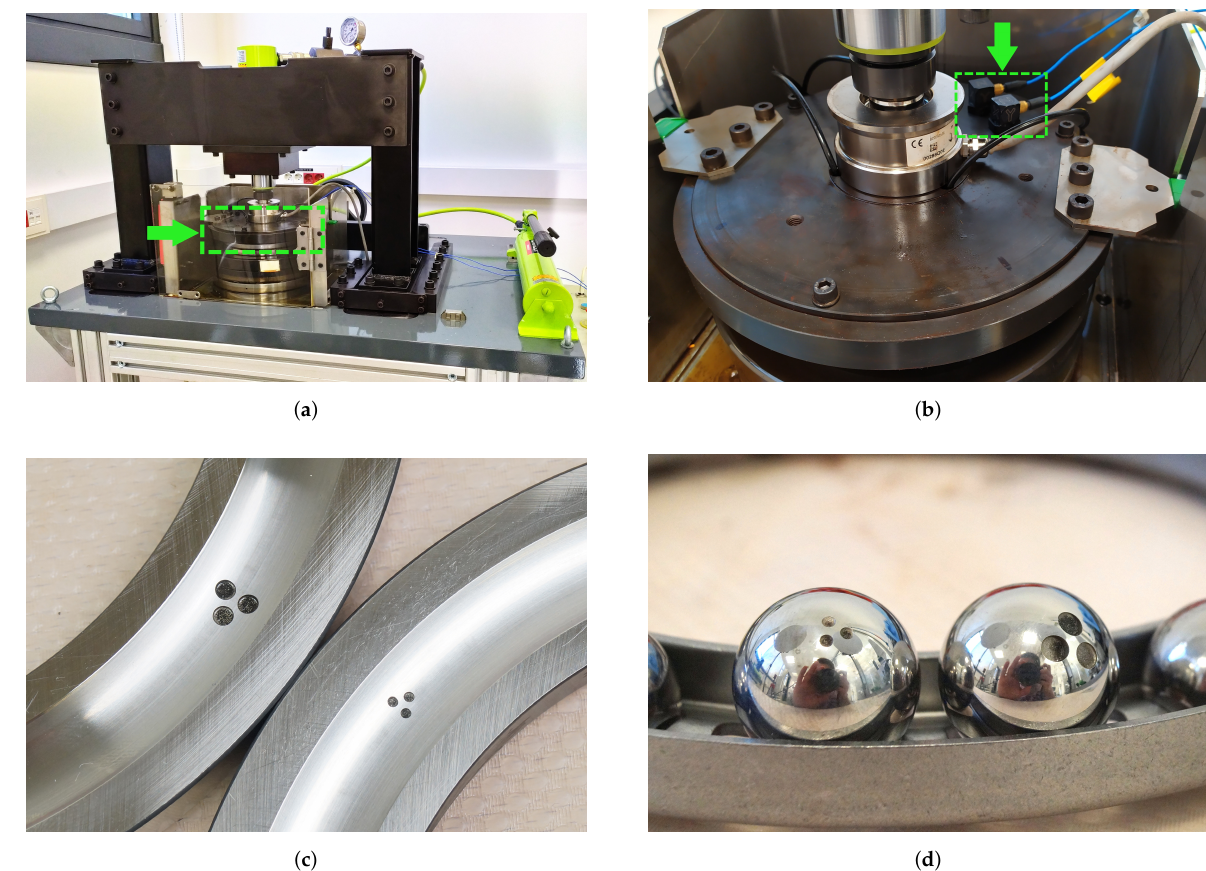
Figure 2. Test rig for low-speed bearings: ( a ) General view of the test rig [74]. The position of the upper support disc is highlighted with a green arrow. ( b ) Detail of the surface of the upper support disc. The position of the sensor is highlighted with a green arrow. ( c ) Damage seeded on shaft washers. ( d ) Damage seeded on ball bearings.